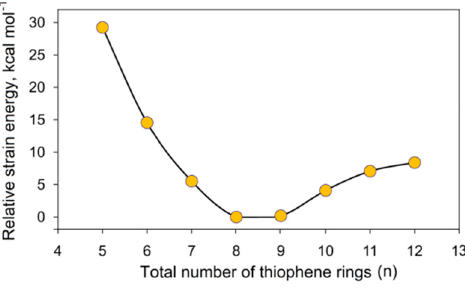
Figure 15. Calculated strain energies for thia[n]circulene species relative to planar octathia[8]circulene 20 at the B3LYP/6–311++G(d,p) level of theory [95].